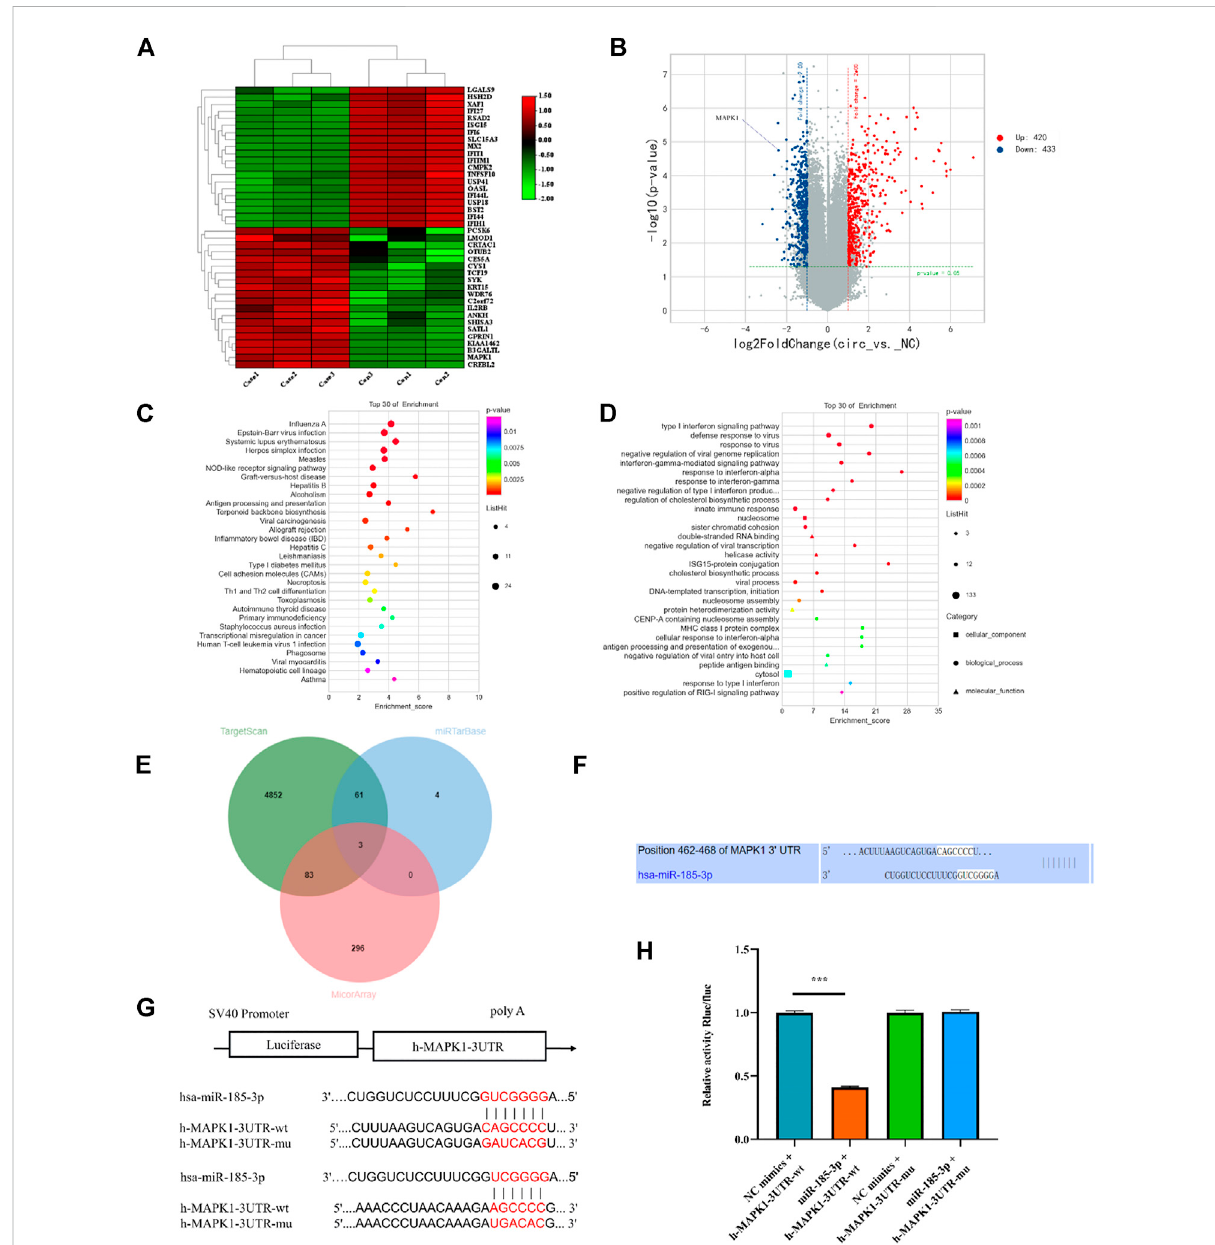
FIGURE 6 mRNA high-throughput sequencing and bioinformatics analyses following silencing hsa_circ_0008870, and luciferase activity between miR- 185-3p and MAPK1. (A) The heatmap of differently expressed mRNAs in hsa_circ_0008870 knockdown chondrocytes (n = 3) and normal control chondrocytes (n = 3). (B) Volcano plot of the signi fi cantly upregulated and downregulated mRNAs. (C,D) The top 30 KEGG pathway and GO enrichment are exhibited. (E) Venn diagram demonstrating the intersection of downregulated mRNAs and predicted target mRNAs. (F) The potentialtargetbindingsitesbetweenmiR-185-3pandMAPK1. (G,H) LuciferaseactivitywasrepressedinhumanchondrocytecotransfectedwithWT MAPK1 and miR-185-3p mimics, while it was restored in cells cotransfected with Mut MAPK1 and miR-185-3p mimics. ***, p <